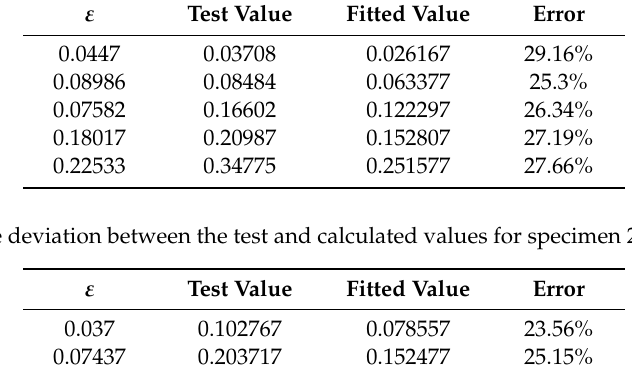
Figure 18. The comparison of stress – strain curves for specimen 2 under different temperatures. Table 10. The deviation between the test and calculated values for specimen 2 under 100 °C. ε